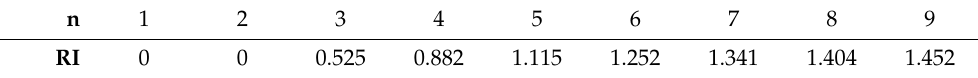
Table 4. Index ratio values based on the order of the comparison